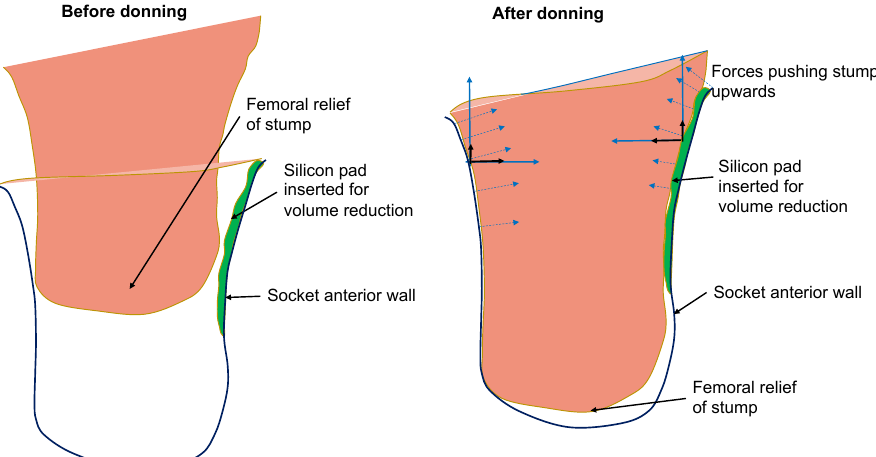
Figure 6. Illustration of rectification action based on silicon-pad insertion for avoiding the develop- ment of distal-end pressures. The forces developed by the silicon pad prevent the stump from sliding deep into the